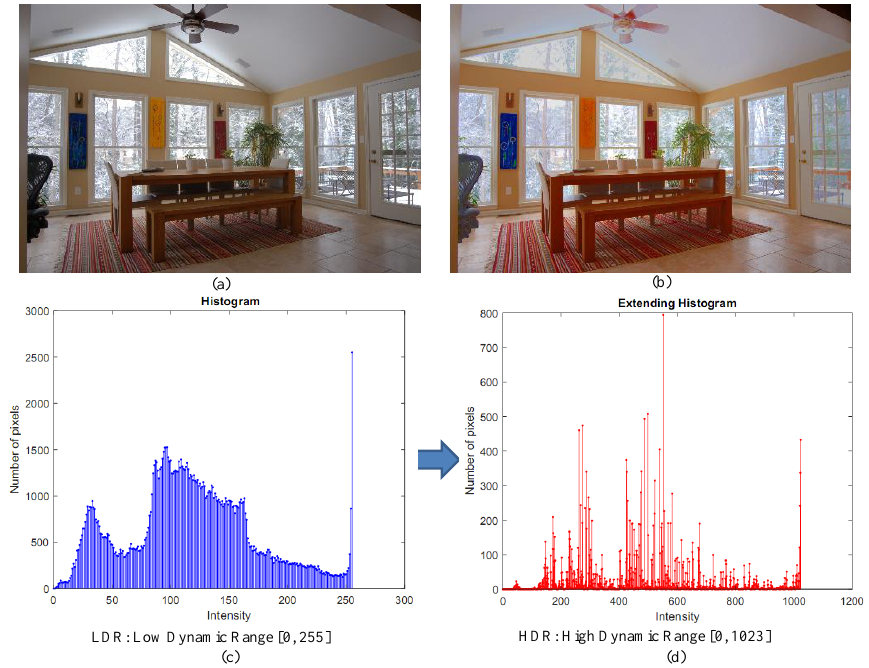
Figure 1. An overview of the proposed method to extend the dynamic range from a single image. ( a , c ) A low dynamic range (LDR) input, and the histogram of the intensity image. ( b , d ) The tone-mapped high dynamic range (HDR) output and the extended histogram of the intensity